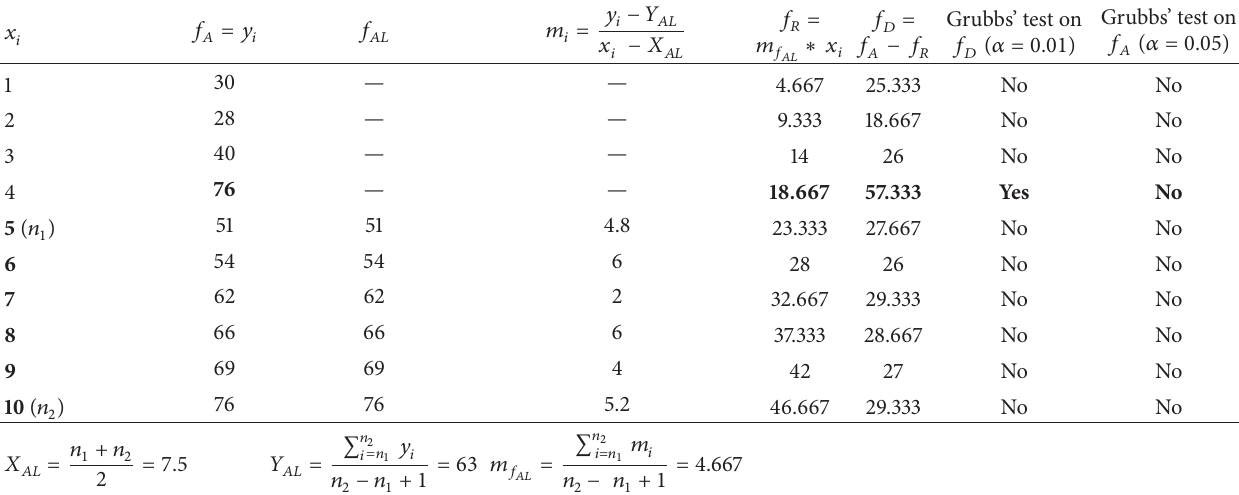
Table 6: Data set 4 ( 𝑛 = 10 ): data set is not continuously incrementing or decrementing. Outlier is neither the first nor the last element. With new transformation technique, Grubbs’ test on 𝑓 𝐷 is capable of identifying the outlier with significance level of